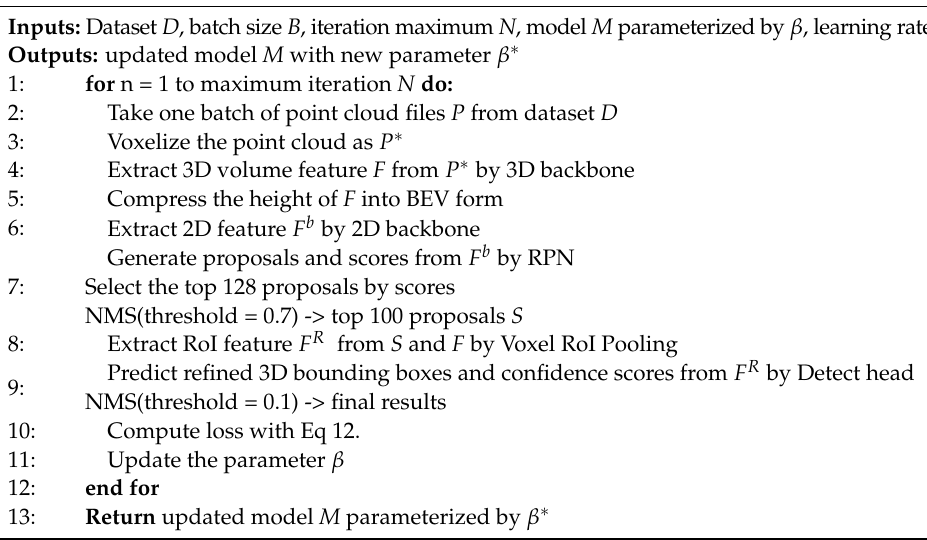
Algorithm 1 Focal Voxel R-CNN training procedure